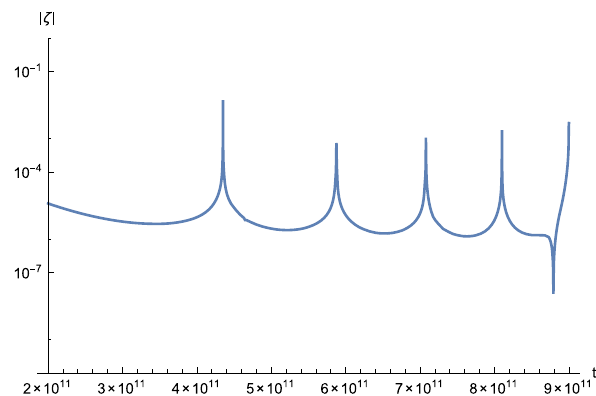
Fig. 7 The numerical plot of | ζ | in terms of the cosmic time t after cur- vaton domination. We choose the parameters as ξ = 1, M = 10 − 4 M p , m = 10 − 6 M p . The initial conditions for δϕ are δϕ i = 10 − 4 M p , ˙ δϕ = 0 i